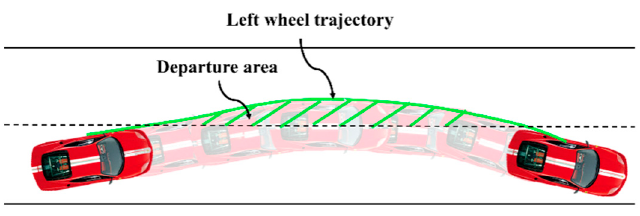
Figure 5. Illustration of departure area.